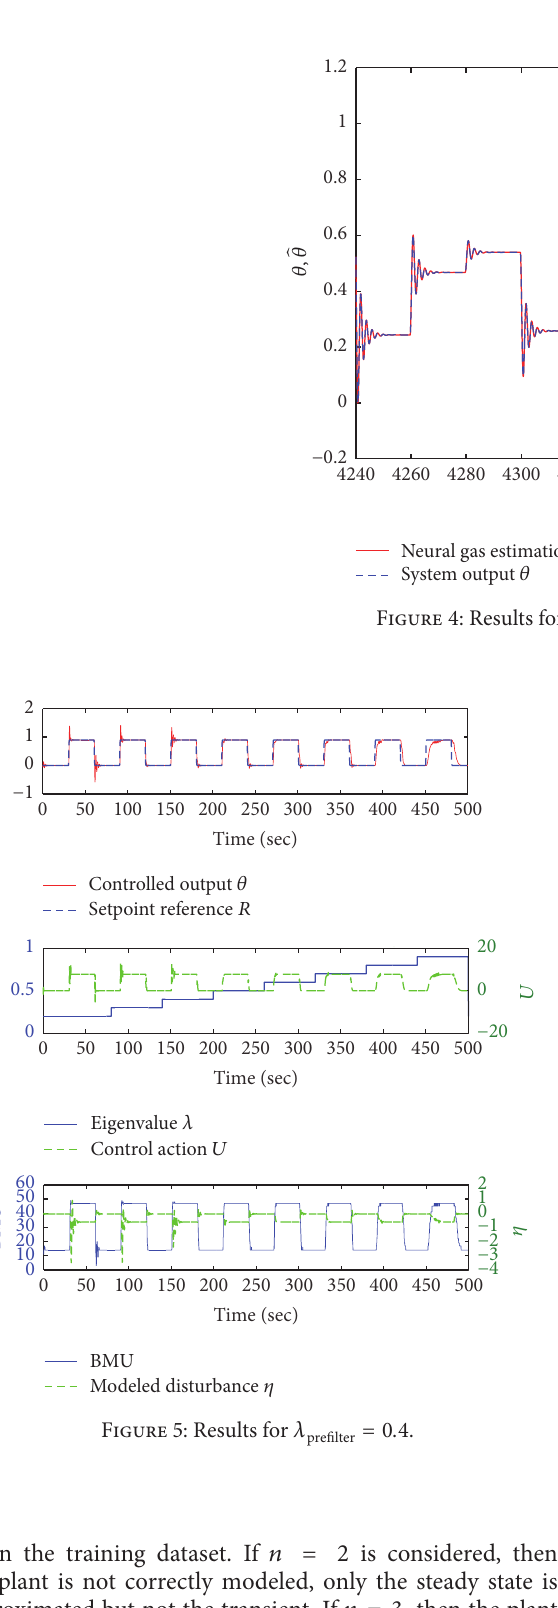
49 neurons to obtain the direct model of the plant. Fewer neurons cause a similar effect to that mentioned above for 𝑛 = 2 and using more neurons does not improve the